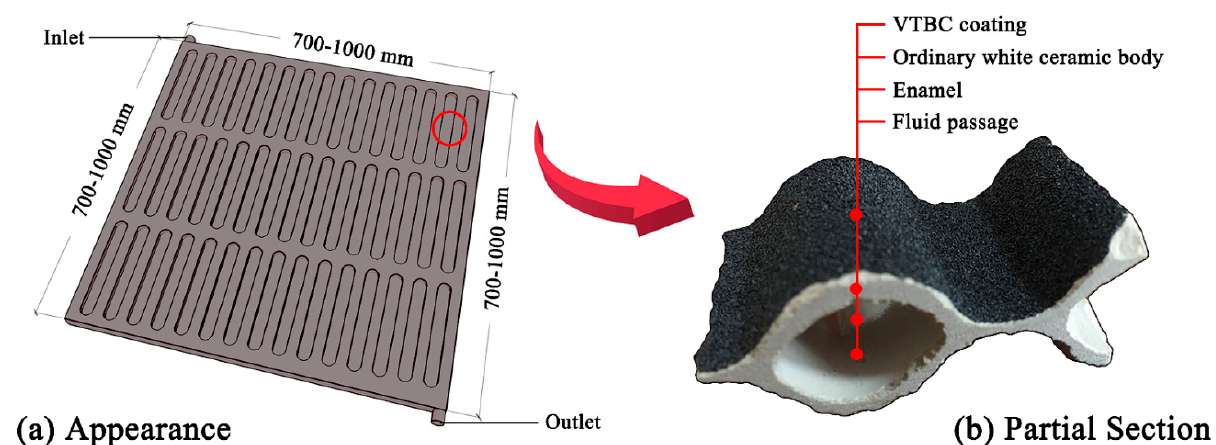
Figure 1. Appearance and partial section of a typical vanadium ‐ titanium black ceramic (VTBC) solar collector.